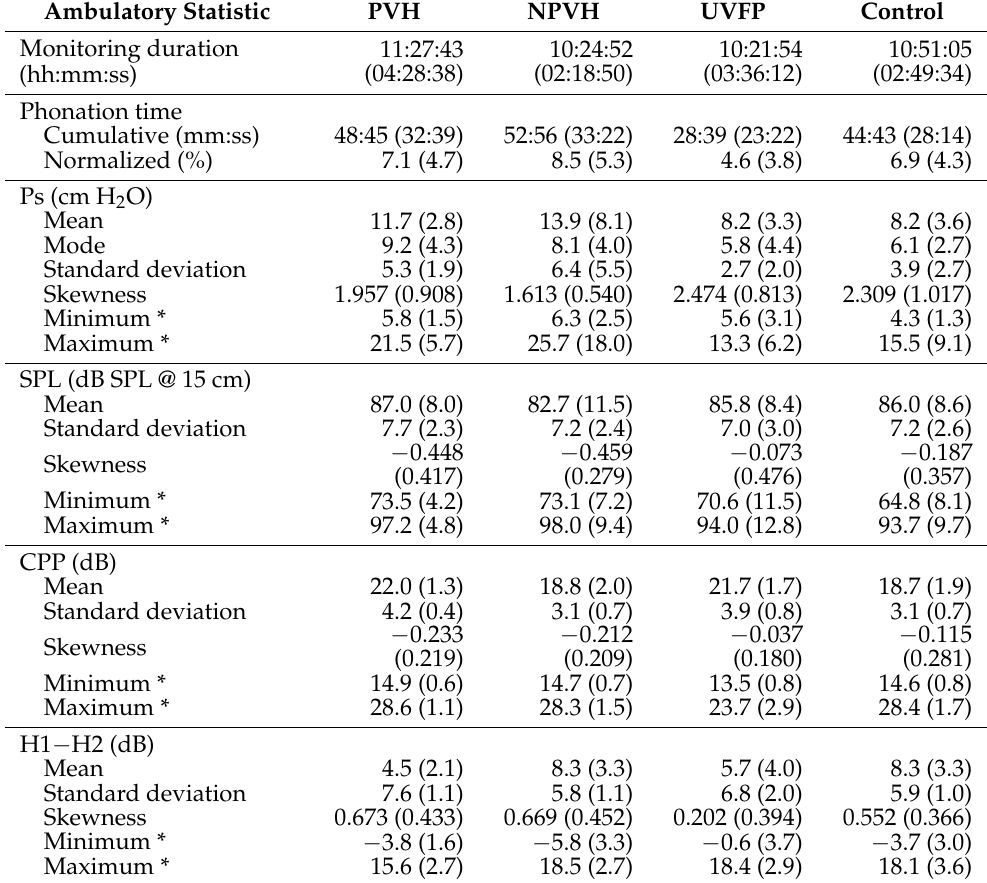
Table 7. Univariate statistics of daylong ambulatory estimates of subglottal pressure (Ps) using Estimation Method 3 (multiple regression model) for each participant group, along with other vocal function measures computed from the accelerometer signal: sound pressure level (SPL), cepstral peak prominence (CPP), and the difference between the first two harmonic magnitudes (H1–H2). Phonation time is reported in minutes and seconds (mm:ss) and percentage units. Group-based f o statistics are not reported due to the known differences in f o for male and female